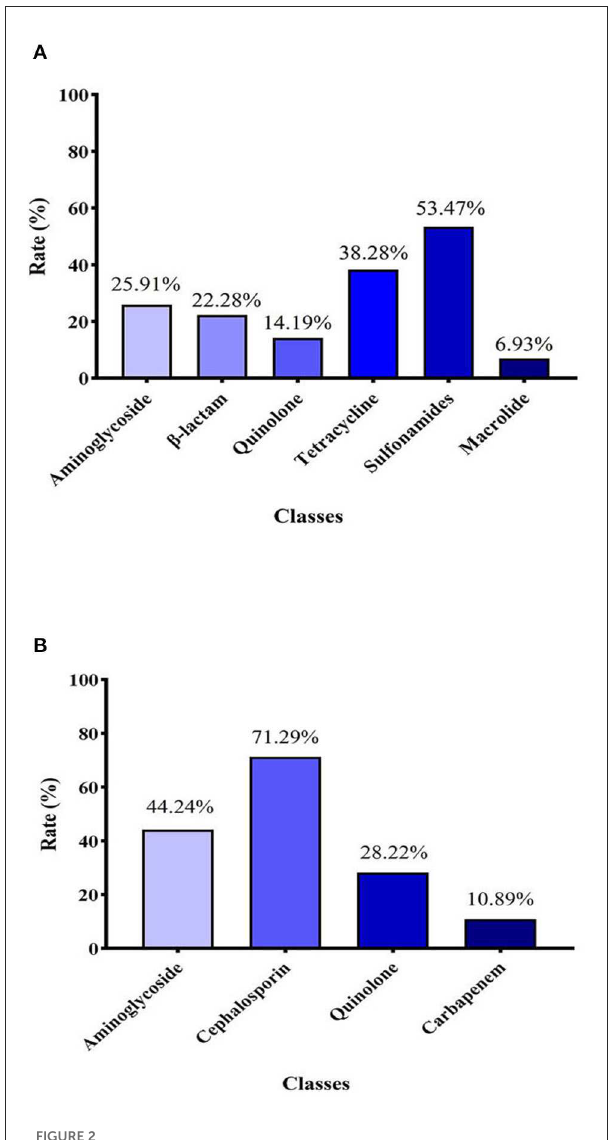
FIGURE2 (A) Detection rate of 6 classes of antibiotical genes among 101 E. coli strains identified. (B) Resistance rates of E. coli strains to four different classes of antibiotics.